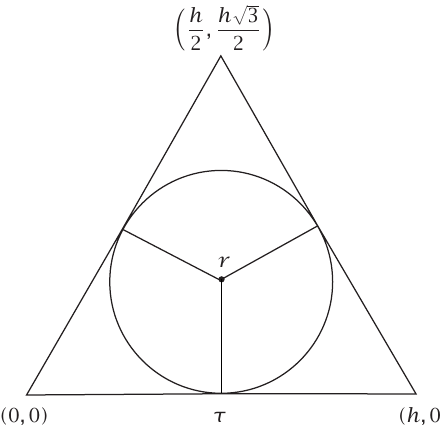
Figure 2.1 . Equilateral triangle with